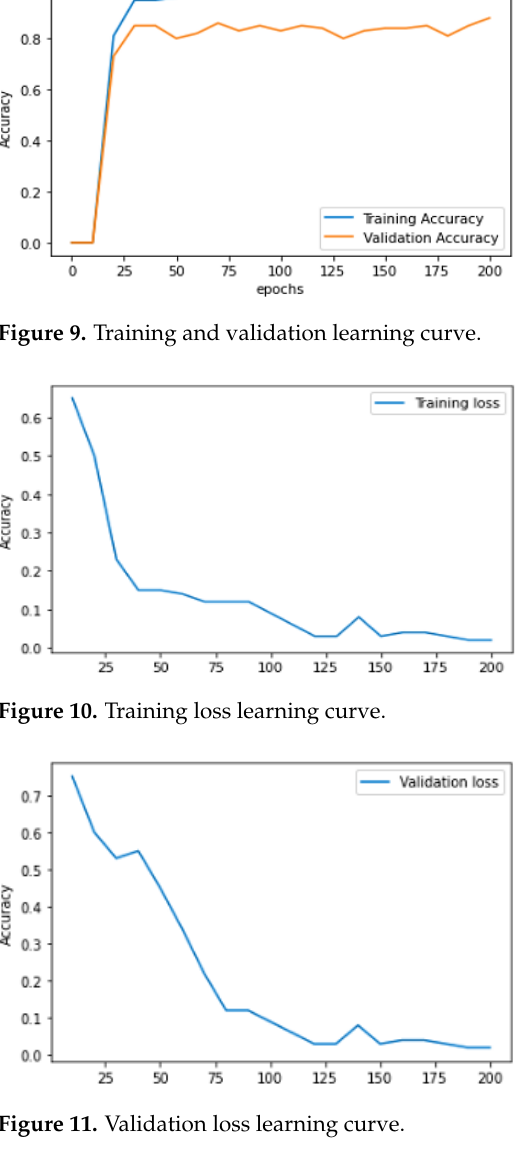
Figure 11. Validation loss learning curve.